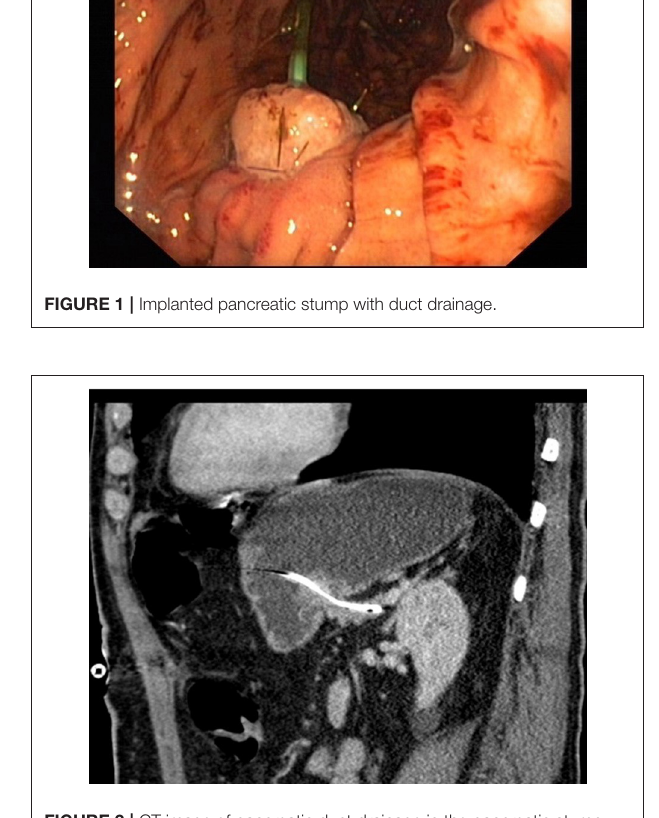
FIGURE 2 | CT image of pancreatic duct drainage in the pancreatic stump and